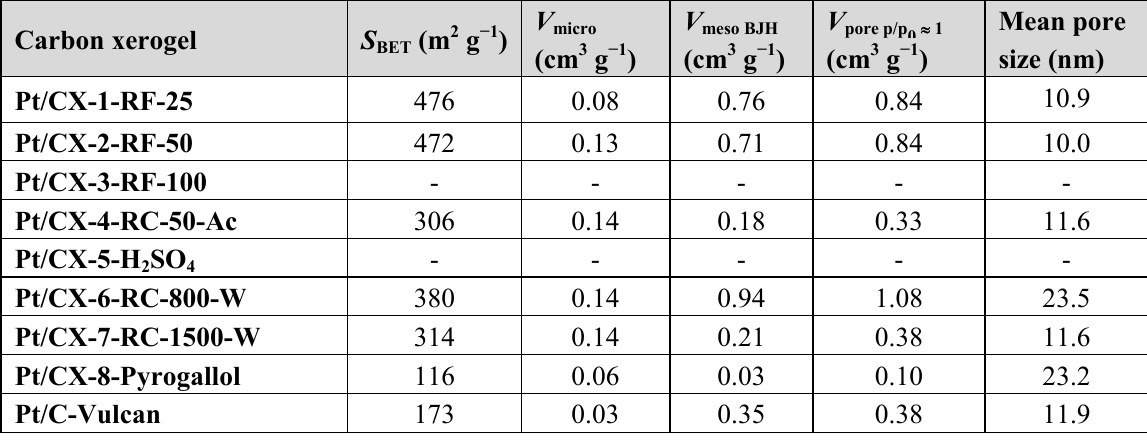
Table 3. BET surface area and pore volumes obtained from N the Pt-catalysts prepared.